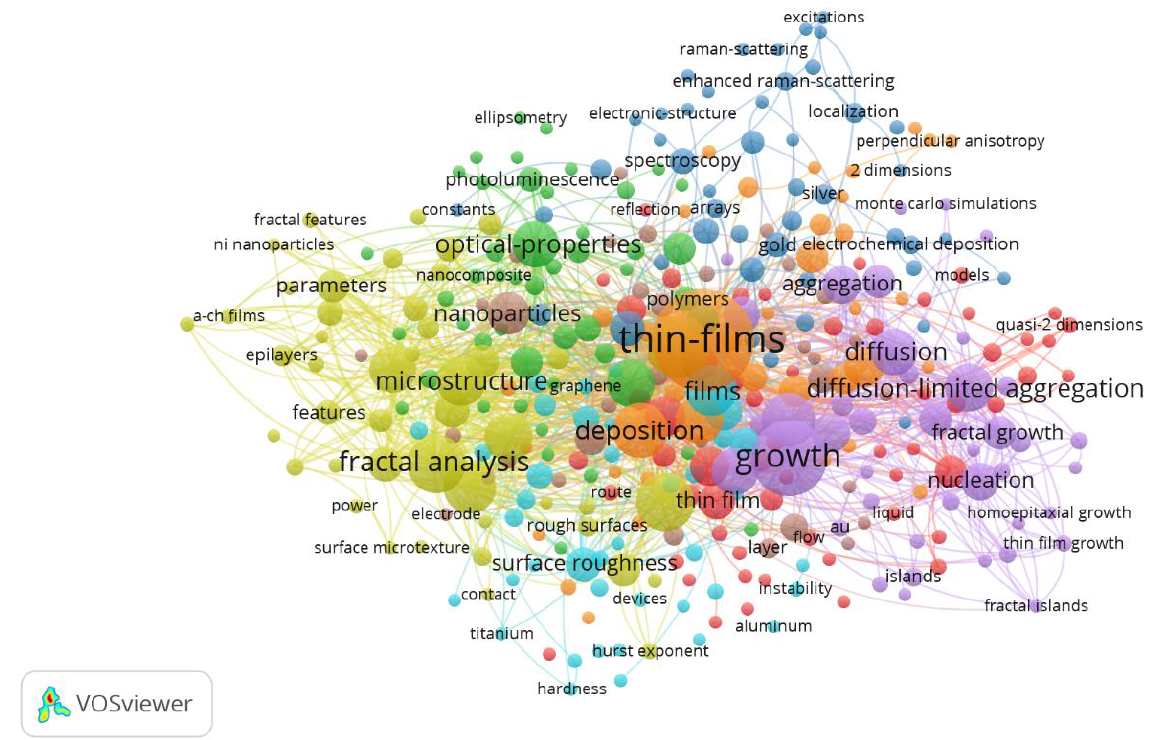
Figure 6. Bibliometric analysis of keywords on fractal theory in thin film applications. In total, eight clusters in different colours are shown in the map.